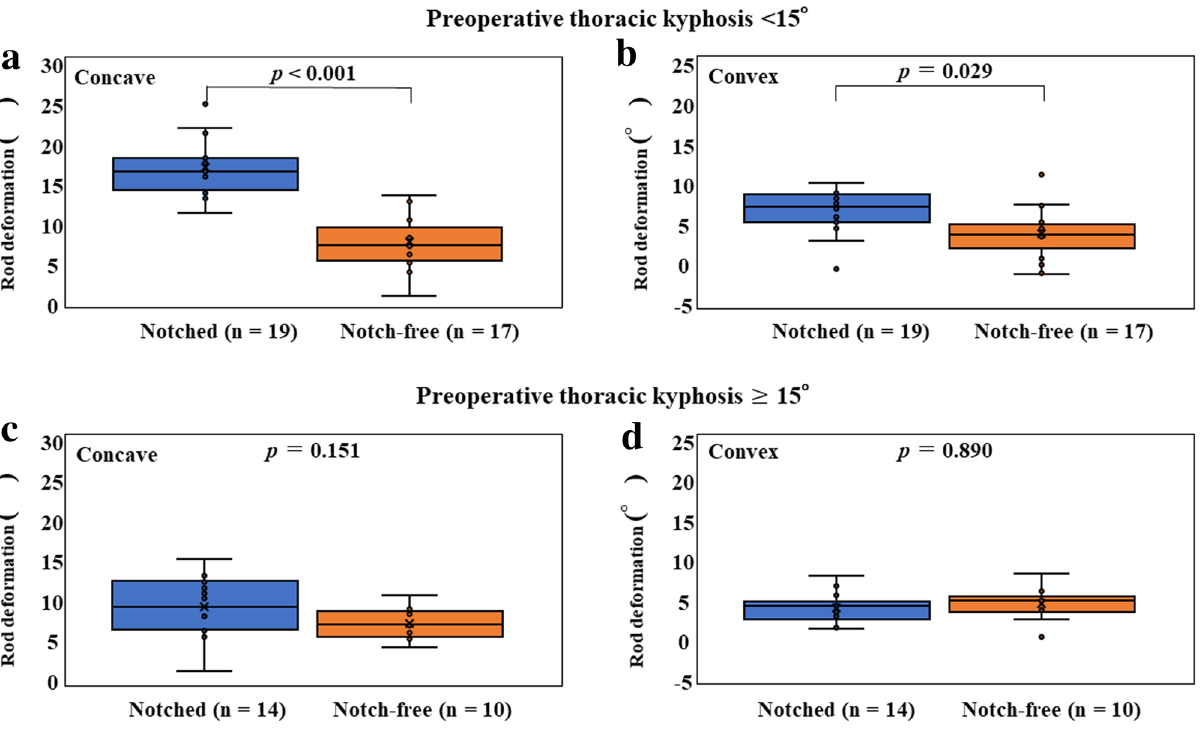
Figure 5. Rod deformation angles in patients with preoperative thoracic kyphosis < 15° (a,b) and ≥ 15° (c,d)